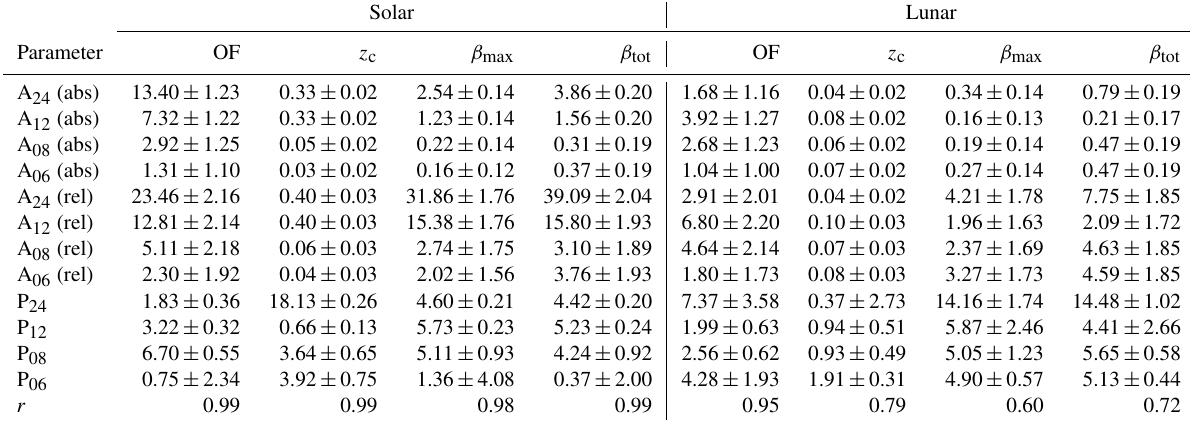
Table 1. Amplitudes (A) and phases (P) of solar and lunar tidal oscillations as determined from harmonic fits with periods of 24, 12, 8 and 6h to the data from 1997 to 2017. Amplitudes are given both in absolute and relative units. Absolute units (abs) are occurrence frequency (OF) in %, altitude ( z c ) in km, maximum brightness ( β max ) in 10 − 10 m − 1 s − 1 and total brightness ( β tot ) in 10 − 7 sr − 1 . Relative units (rel) are in % with respect to the mean value. Fit quality is given as the correlation coefficient r